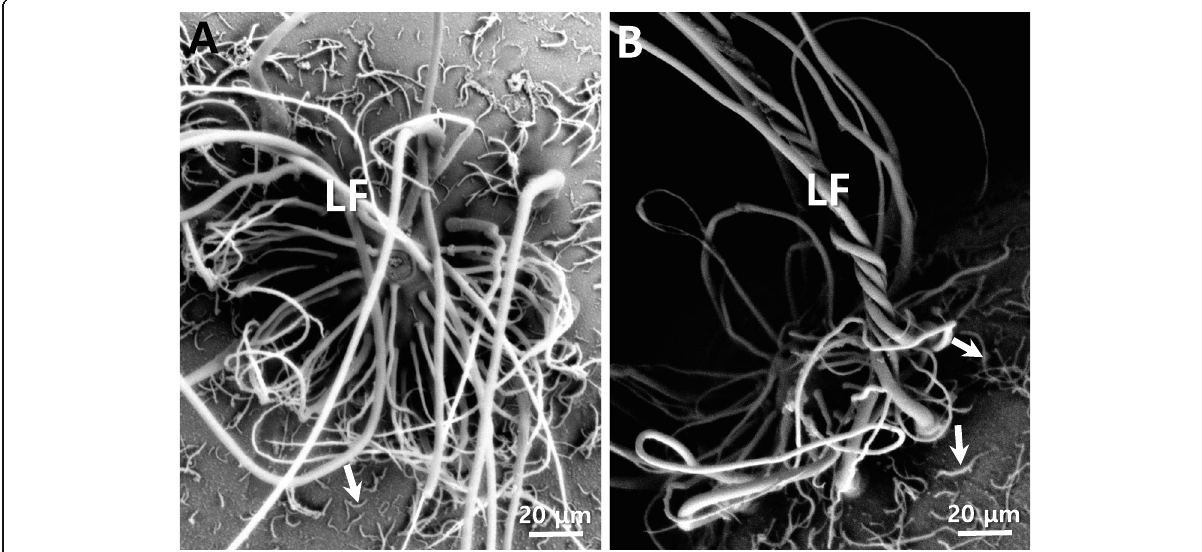
Fig. 2 Long adhesive filaments (LF) from the fertilized eggs of M. praecox were only at the area of the animal pole including a micropyle ( a ) and the short adhesive filaments (arrows) were around long adhesive filaments. Sometimes the long adhesive filaments were coiled together ( b